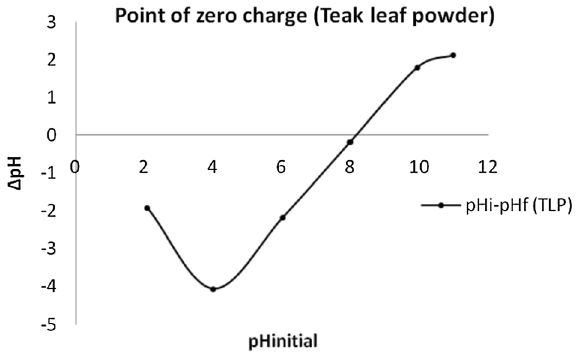
Fig. 7 SEM analysis of raw TLP after adsorption